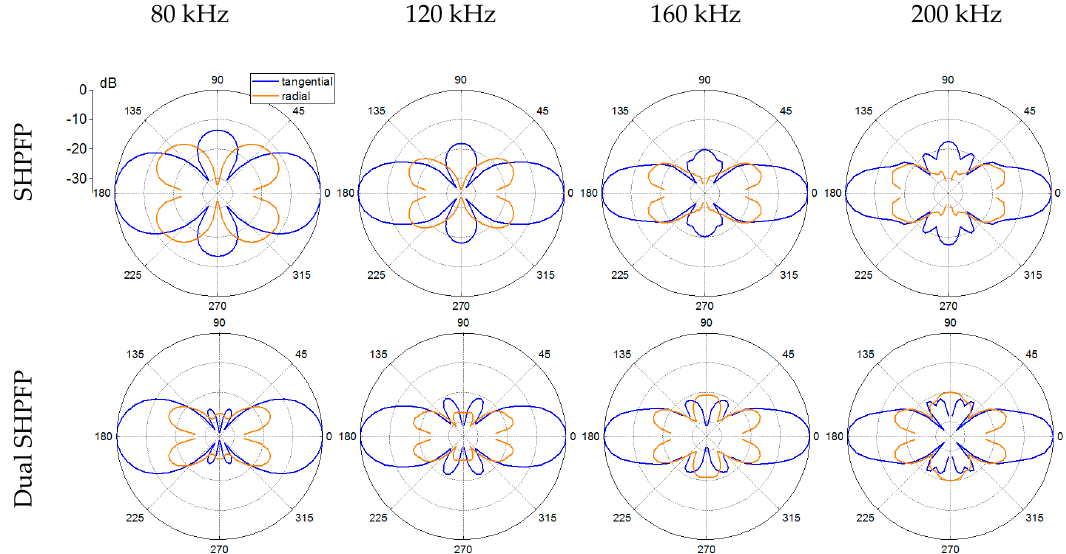
Figure 16. Polar plots of the maximum values of the surface velocity components. The plots of the original SHPFP and the dual SHPFP are compared for different center frequencies. The blue lines show the SH0 wave’s amplitude and the orange lines show the unwanted S0 Lamb wave’s amplitude. The values in each polar diagram were normalized to the maximum value of each graph. The scale is in dB and all values below − 35 dB are cut off. Table 2. Comparison of the purity ratio at different center frequencies.